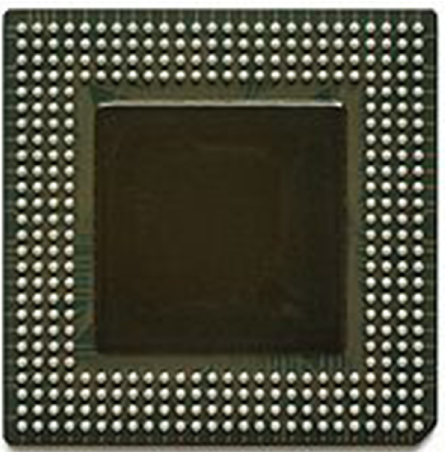
Fig. 1. The bottom view of an Intel Embedded Pentium MMX.